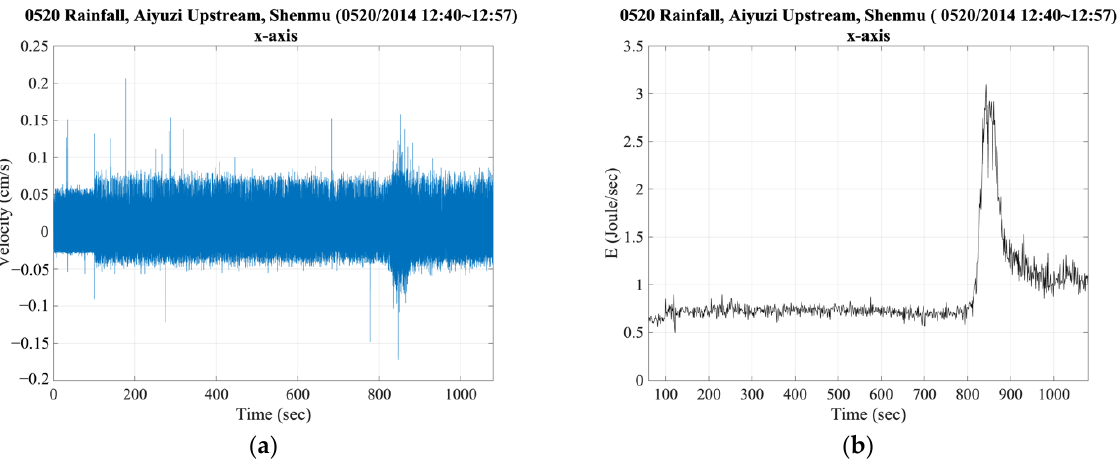
Figure 6. The data of 0520 Rainfall in 2014 ( a ) vibration signals ( b ) accumulated energy per second.